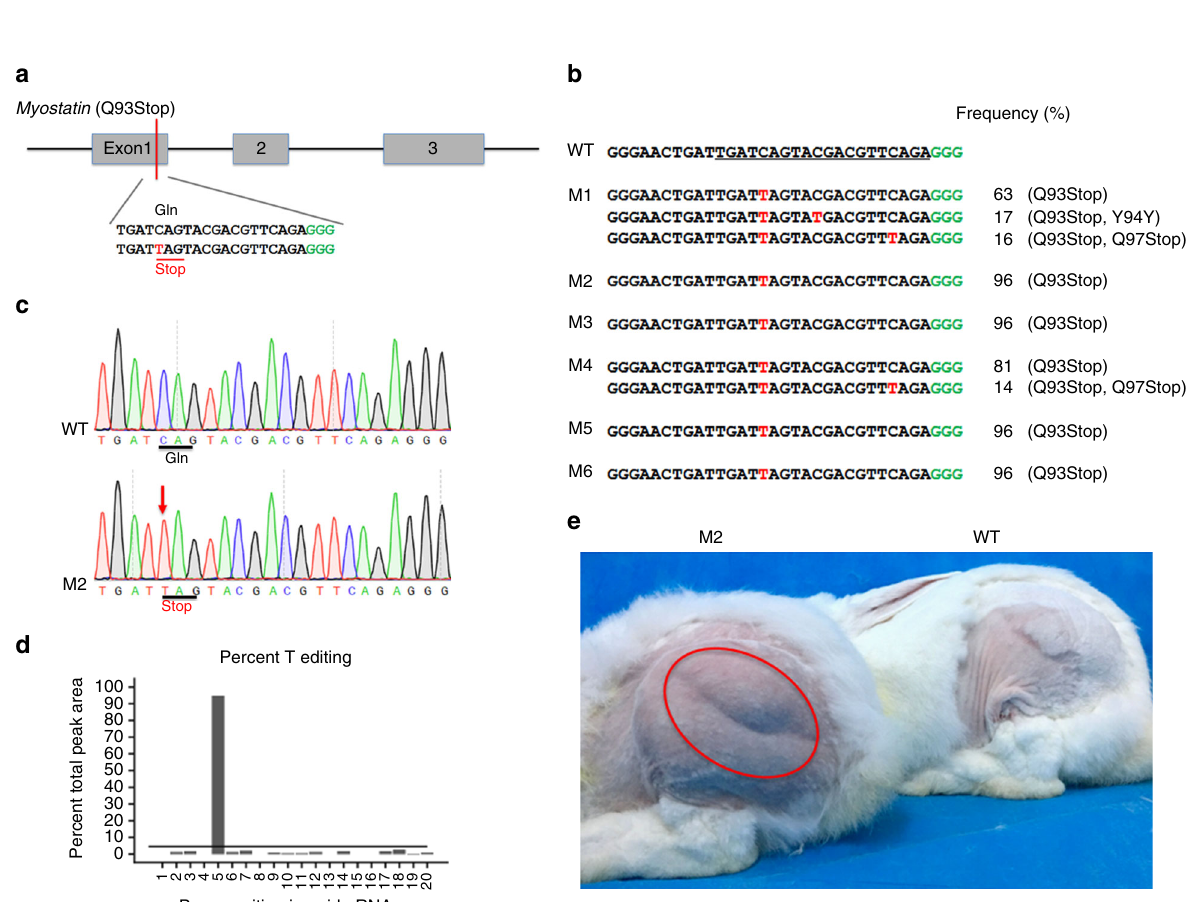
Fig. 2 Generation of double-muscled rabbits using BE3 system. a The target sequence at the Mstn locus. The PAM-target and sgRNA-target sequences are shown in green and black, respectively. The substituted bases are marked in red. b Alignments of mutant sequences from targeted deep sequencing. The targeted sequence is underlined. PAM site and substitutions are shown in green and red, respectively. The column on the right indicates frequencies of mutant alleles. WT wild-type. c Sanger sequencing chromatograms of DNA from WT and Mstn mutant rabbits (M2). The red arrow indicates the substituted nucleotide. Relevant codon identities at the target site are presented beneath the DNA sequence. d The predicted editing bar plot based on Sanger sequencing chromatograms from M2 by EditR. e Mstn mutant rabbits exhibited a double-muscle phenotype (red circle, M2) at 3